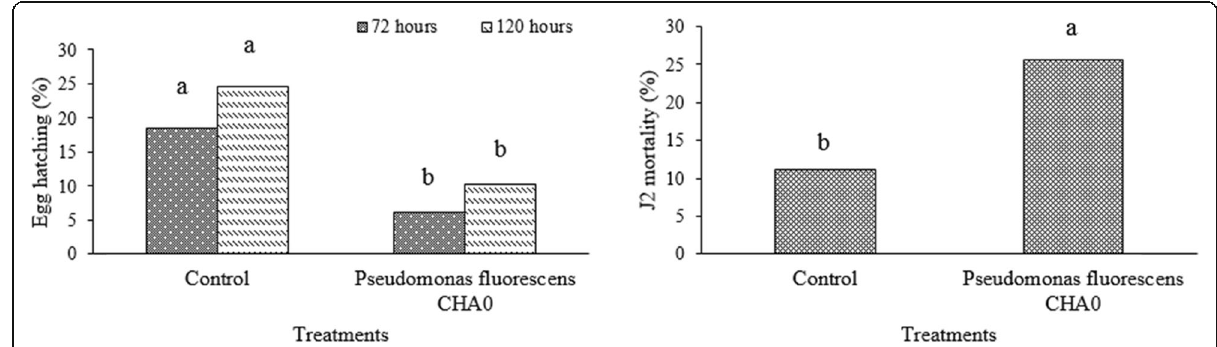
Fig. 1 Mean egg hatching and mortality (%) of Meloidogyne javanica juveniles exposed to Pseudomonas fluorescens CHA0 at a concentration of 10 8 CFU/ml. Means are average of four replications. Means in a column followed by the same letter(s) are not different according to LSDs ( p ≤ 0.01)